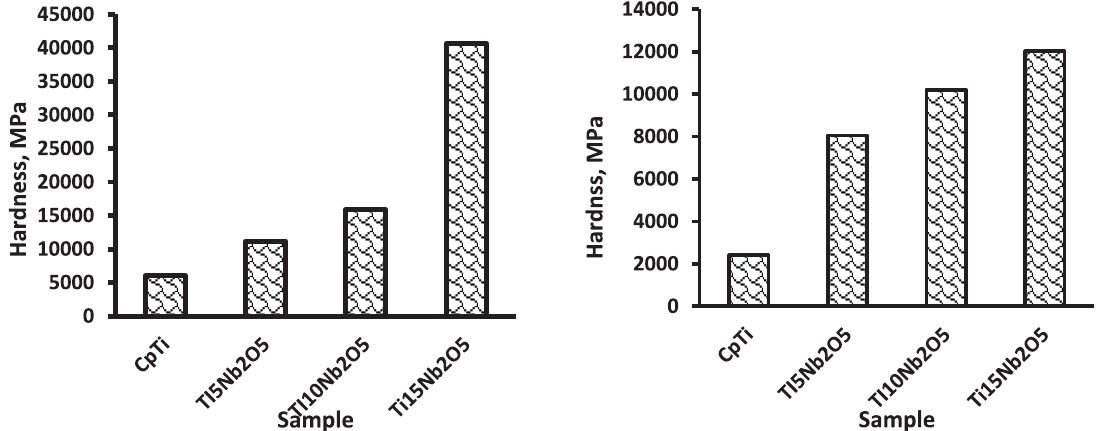
Fig. 5. (a) showing hardness of the material at 20mN (b) hardness at